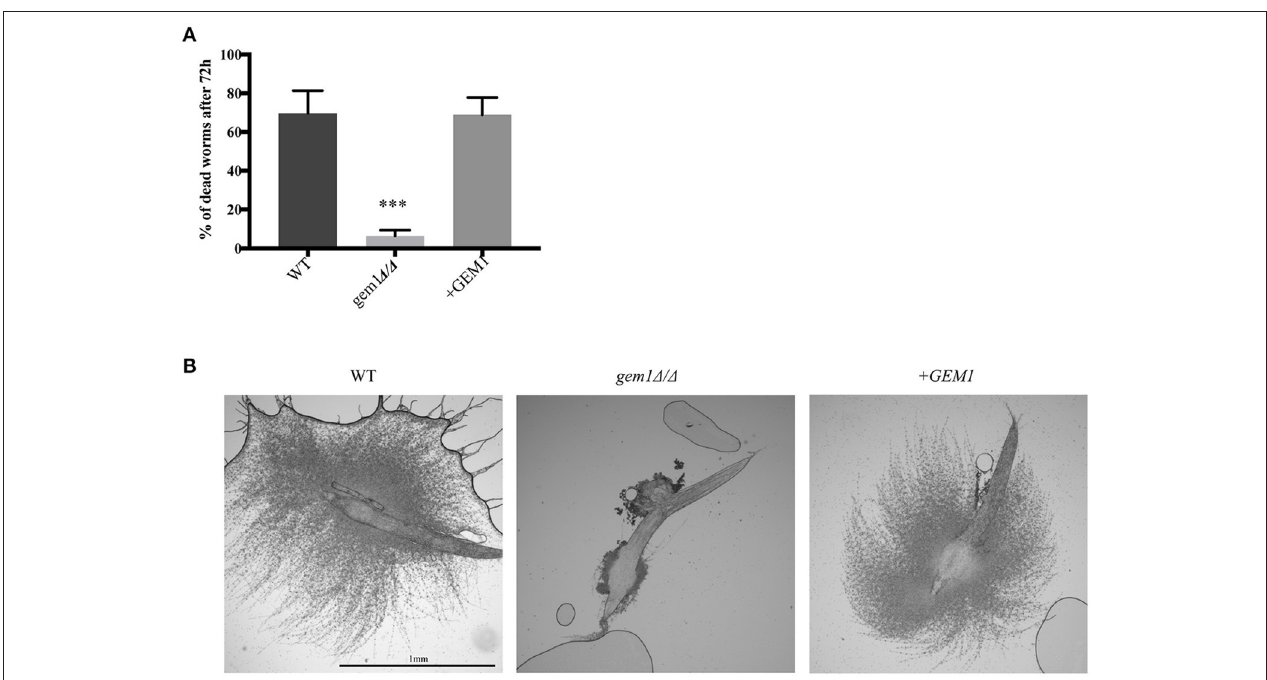
FIGURE 6 | Gem1 is required for virulence of C. albicans . (A) . The worm C . elegans was infected with wild type, gem1 1 / 1 or the complemented + GEM1 strain, and dead worms counted after 72h. The mean and standard deviation of three independent experiments is shown. Statistical significance was determined by unpaired t -test with Welch’s correction*** p < 0.005. (B) Penetrative filamentation was monitored and pictures were taken after